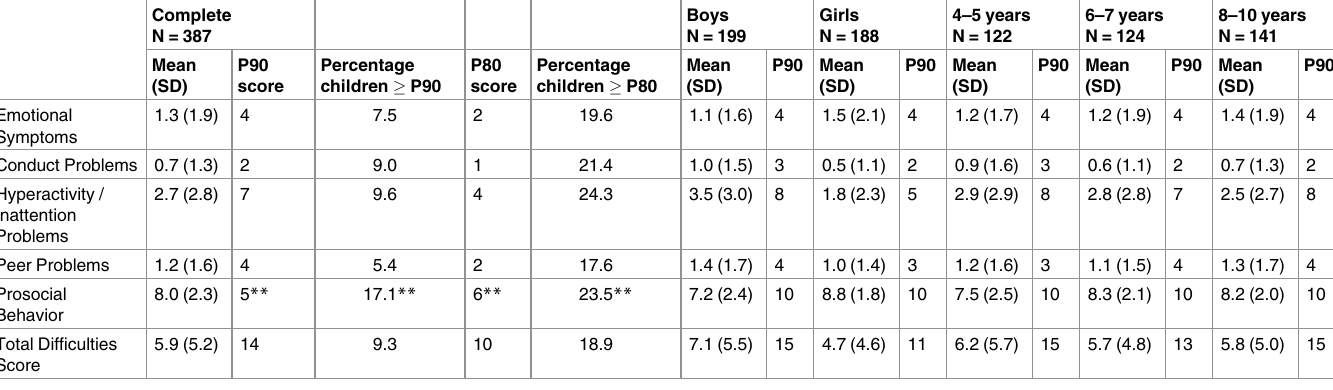
Table 2. Mean scores, standard deviations (SD) and clinical cut-off scores (p90 * & p80) for the